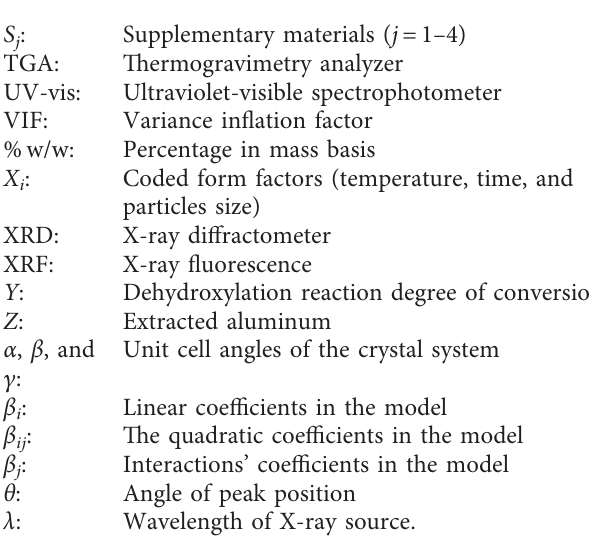
Table S1. Summary of statistics in model selection for degree of conversion. Table S2. Quadratic model ANOVA analysis regression coefficient estimates, standard error, 95% CI, and VIF values for degree of conversion. Table S3. Summary of statistics analysis in model selection for extracted aluminum. Table S4. Quadratic model ANOVA analysis